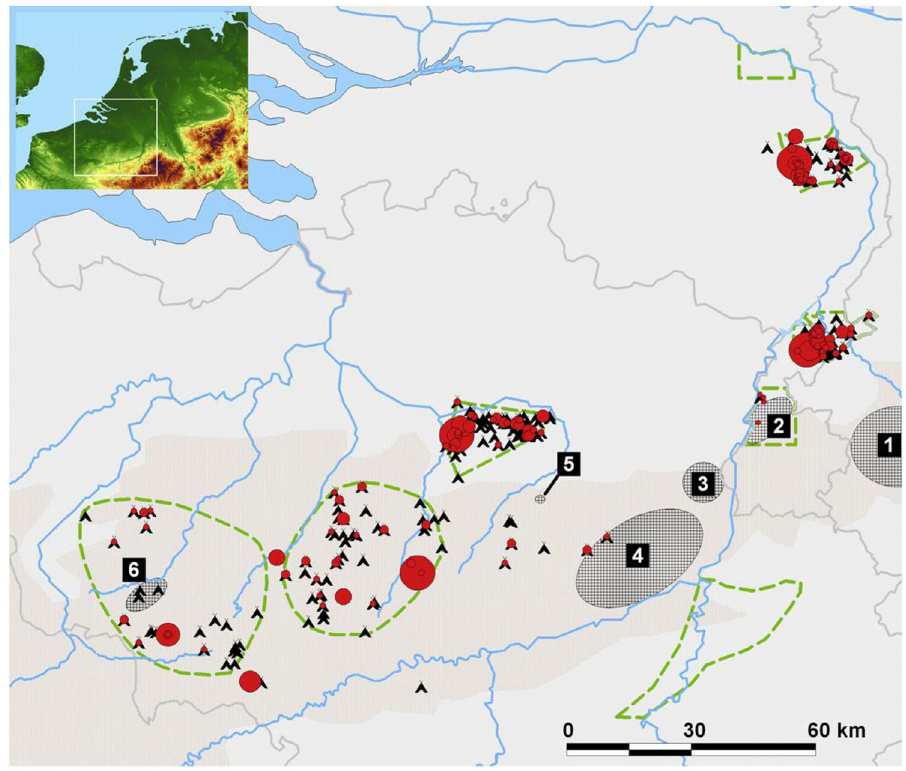
Figure 3: Spatial distribution of microliths in the loess area and its margins, with localisation of LBK clusters ( after Vanmontfort, 2008, Figure 5 )